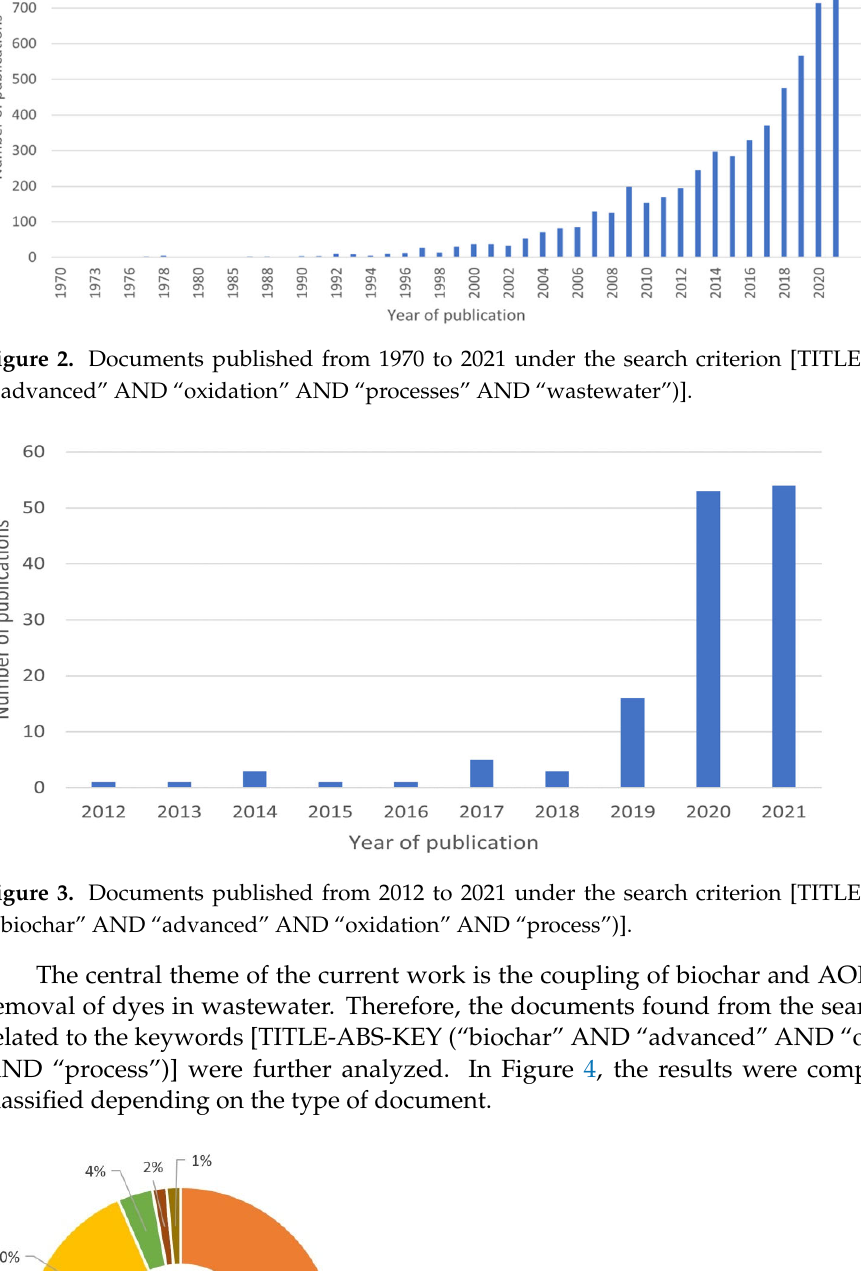
Figure 1. Documents published from 2009 to 2021 under the search criterion [TITLE ‐ ABS ‐ KEY (“bi ‐ ochar” AND “wastewater”)].